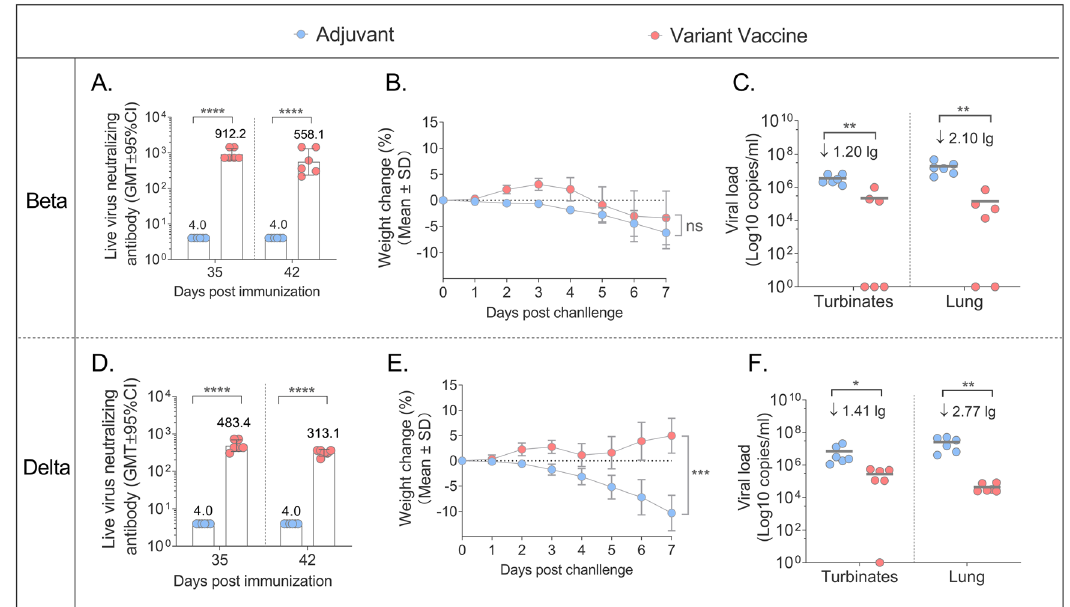
Fig. 5 Immune responses and protective ef fi cacy in vaccinated golden Syrian hamsters. A Live virus neutralizing responses agianst Beta strain (GMT ± 95%CI). B The weight changes (%) of the hamsters post the challenge with Beta strian (Mean±SD). C Viral loads of lungs and nasal turbinates determined by qRT-PCR on the 7 days post the Beta strian challenged. The centre line are shown as Means. D Live virus neutralizing antibody titers agianst Delta strain (GMT ± 95%CI). E The weight changes (%) of the hamsters post the challenge with Delta strian (mean ± SD). F Viral loads of lungs and nasal turbinates determined by qRT-PCR on the 7 days post the challenge with Delta strian. The centre line are shown as Means. Note: * p < 0.05; ** p < 0.01; **** p < 0.0001.